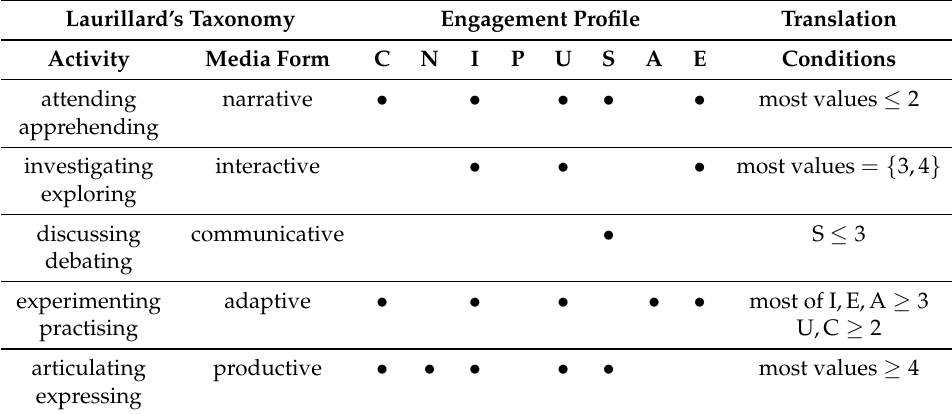
Table 1. The entries marked with • show the properties of the Engagement Profile that have an impact on the media forms of Laurillard’s taxonomy. The last column shows the translation conditions when a media form is